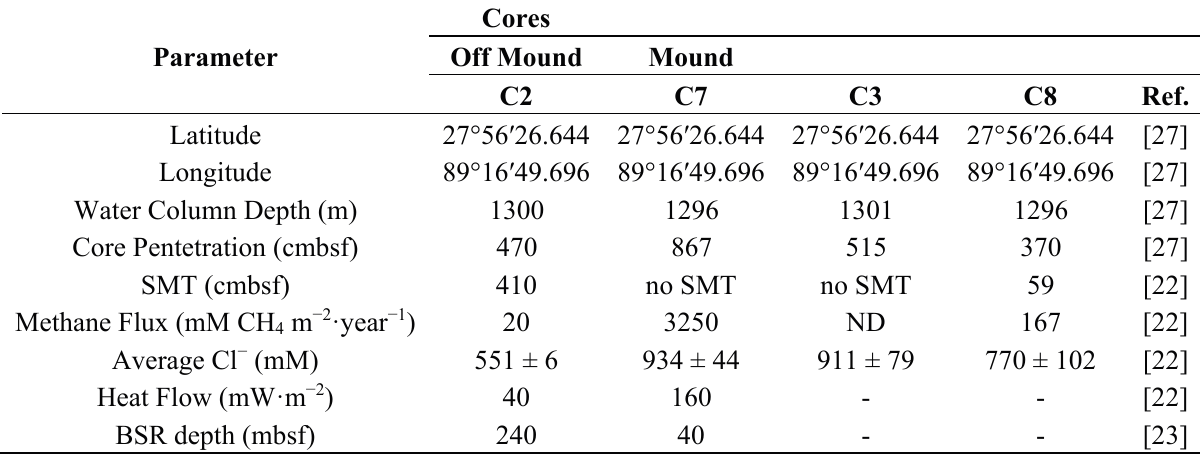
Table 1. Review of previously published data for core sites on- and off-mound. Where data is general for the mound and not located at specific stations it is listed under